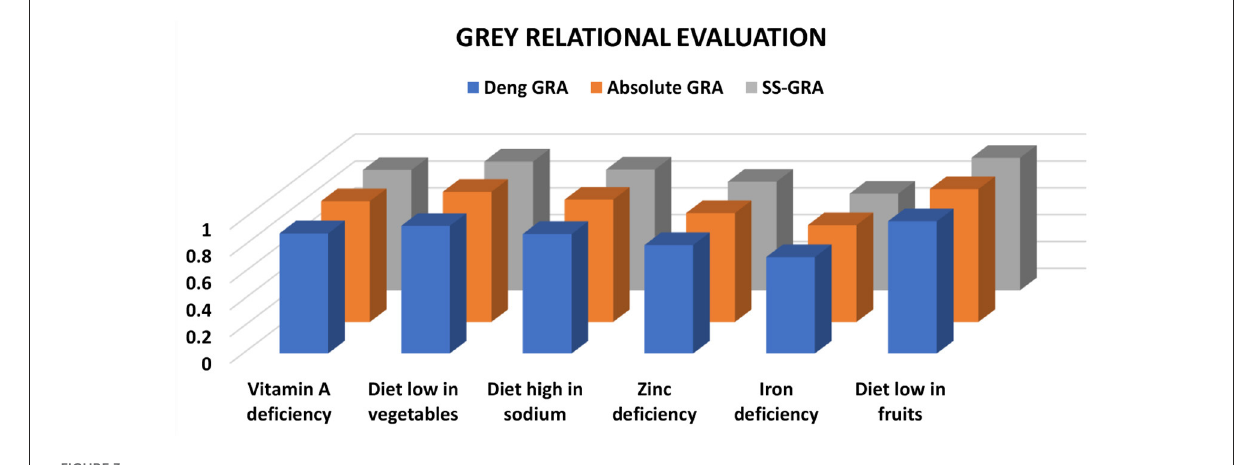
FIGURE3 GRA assessment between stroke and nutritional variables.